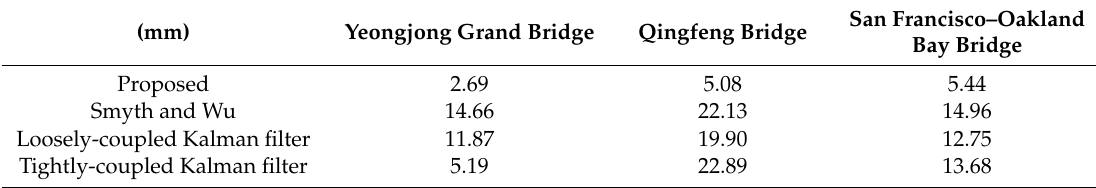
Table 2. Estimation accuracy comparison of the proposed method to the displacement estimation method proposed by Smyth and Wu and loosely and tightly-coupled Kalman